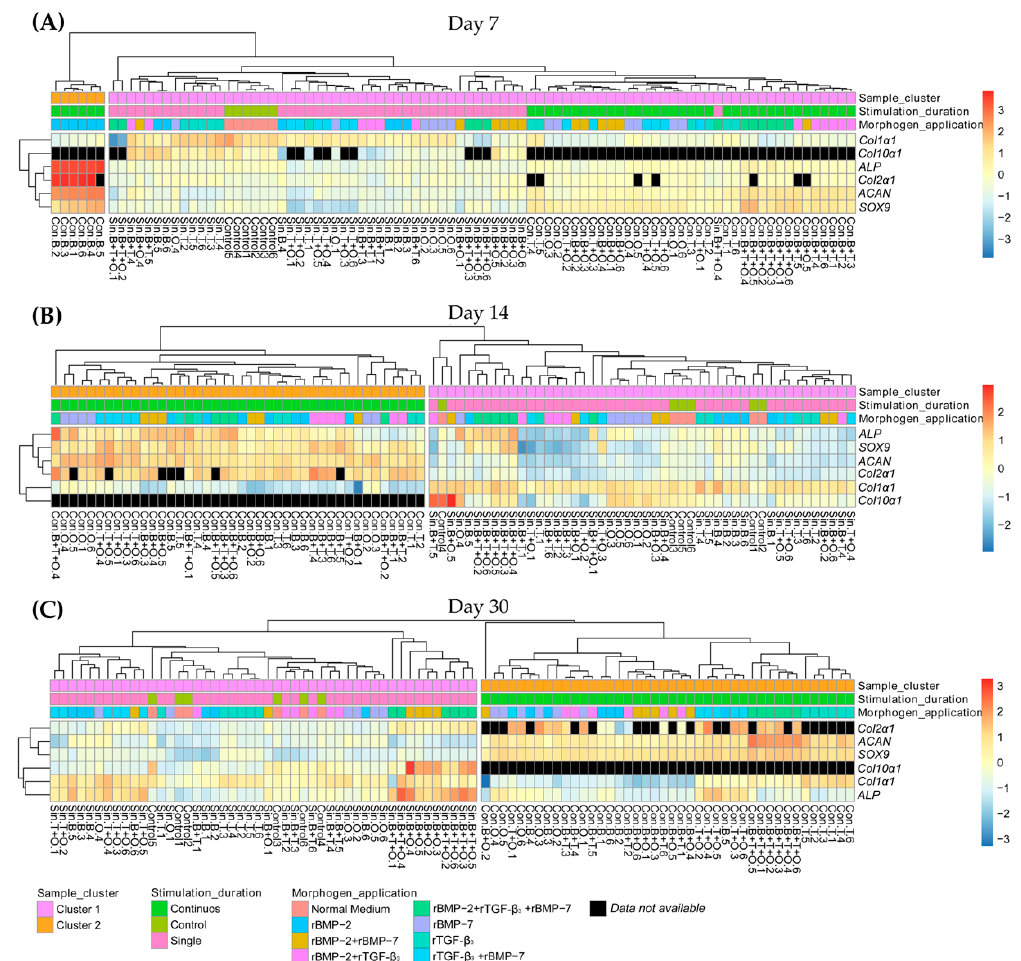
Figure 10. Hierarchical clustering of gene expression of all the samples at day 7 ( A ), 14 ( B ) and 30 ( C ). The distance measure used in the clustering rows and column was Euclidean, the agglomeration method used to cluster was the average. Con. = Continuous, Sin. = Single, B = rBMP-2 treated group, T = rTGF- β 3 treated group, O = rBMP-7 treated group, B + T = rBMP-2 + rTGF- β 3 treated group, B + O = rBMP-2 + rBMP-7 treated group, T + O = rTGF- β 3 + rBMP-7 treated group, B + T + O = rBMP-2 + rTGF- β 3 + rBMP-7 treated group, ACAN = aggrecan , SOX9 = sex-determining region Y (SRY)-box 9 , Col2 α 1 = collagen type II alpha 1 , Col1 α 1 = collagen type I alpha 1 , Col10 α 1 = collagen type X alpha 1, ALP = alkaline phosphatase.